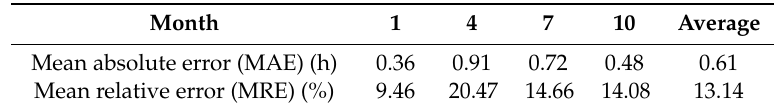
Table 3. Summary of model evaluation using Inverse distance weighting ( IDW) and kriging.